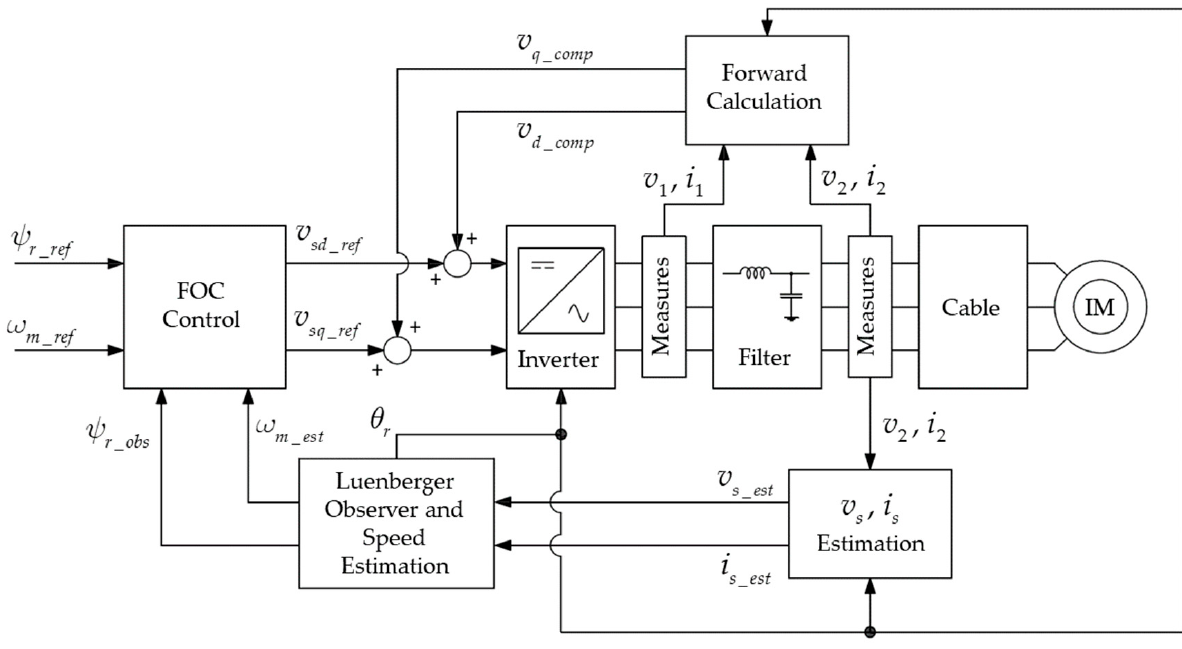
Figure 8. SCDFOC block diagram implementation.